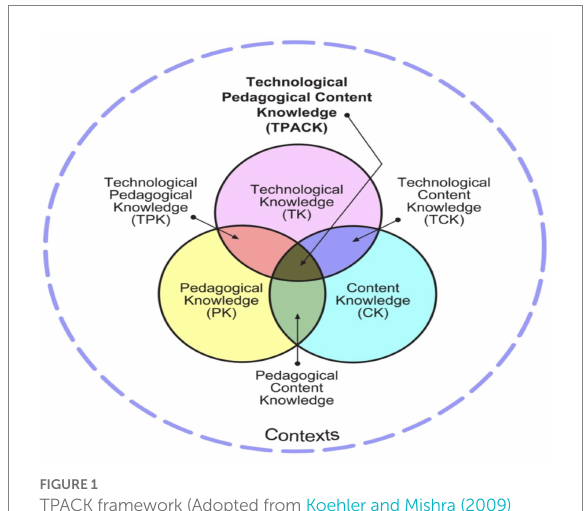
FIGURE 1 TPACK framework (Adopted from Koehler and Mishra (2009)